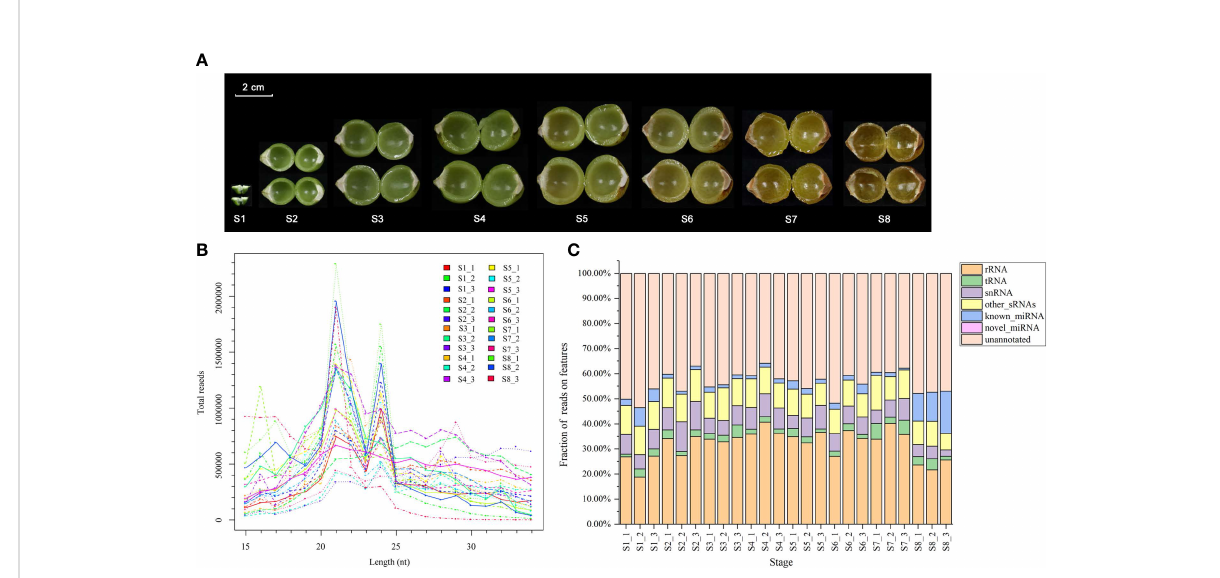
FIGURE 2 Diversity of sRNAs in soapberry. (A) Images of eight pericarp developmental stages from soapberry. (B) The length distribution of reads in the eight stages. (C) Small RNAs annotation in the Rfam databases. Fractions of different annotations are presented in a stacked bar